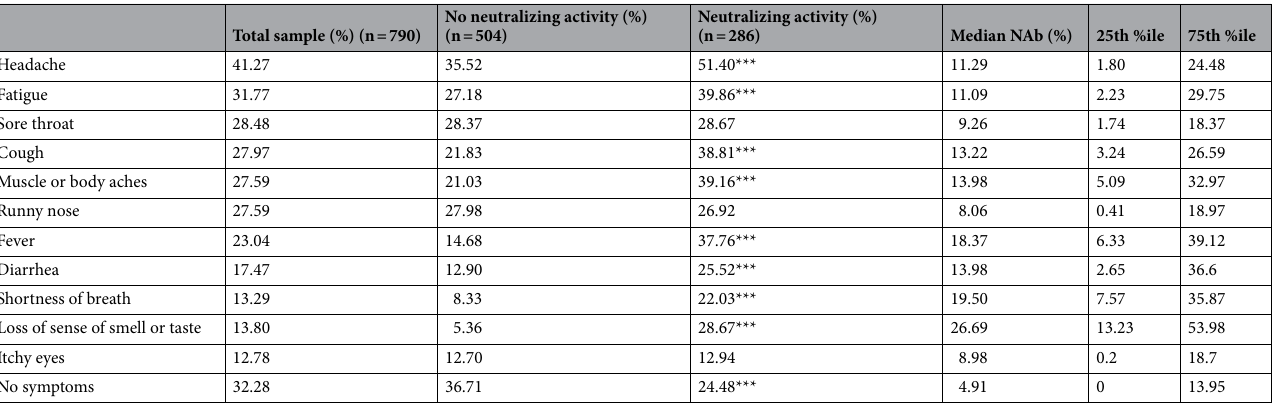
Table 2. Prevalence of reported symptoms of SARS-CoV-2 infection within the total seropositive sample, proportion of individuals with and without neutralizing antibody activity, and magnitude of surrogate neutralization activity by symptom for seropositive individuals. N = 790. Pearson chi-square test of independence: ***p <